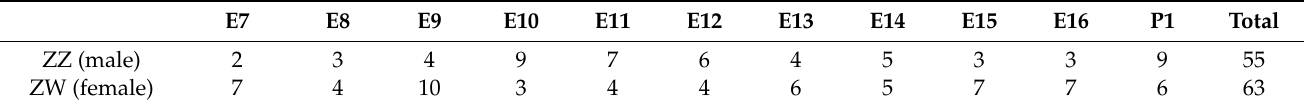
Figure 1. Cloning and sequence analysis of the coding sequence (CDS) of quail METTL3 . ( A ) PCR products of CHD1 gene amplification. The products observed in different lanes are derived from distinct quail individuals. ( B ) Agarose gel electrophoresis of 3 ′ RACE-PCR products. The products observed in different lanes represent the same product obtained from various PCR tubes. ( C ) The western blotting analysis of the METTL3-3 × flag fusion protein and the negative control. The initial three lanes depict the protein products of blank vector with 3 × flag and eGFP-fused, whereas the latter three lanes represent the protein products of quail METTL3 fused with 3 × Flag and eGFP. ( D ) The phylogenetic tree generated for METTL3. (Please find the WB full membrane and the full images of agarose gel electrophoresis of Figure 1 in Figure S1). Table 2. Count of quail embryos by